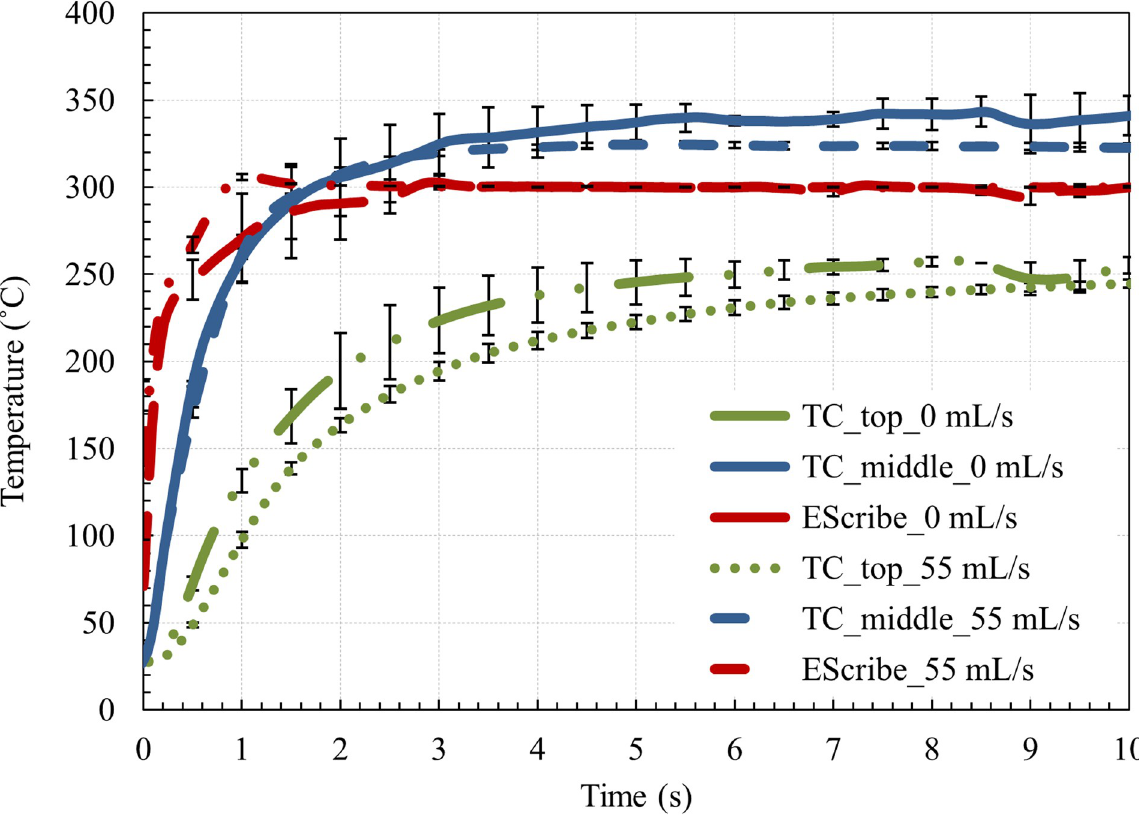
Fig 3. Coil temperature recorded by TCs and EScribe for two flow rates of 0 mL/s and 55 mL/s. Long dash dot dot green line: temperature measured at the top section of the coil for the air flow rate of 0 mL/s, solid blue line: temperature measured in the middle section of the coil for the air flow rate of 0 mL/s, long dash red line: temperature measured by EScribe for the air flow rate of 0 mL/s, dot green line: temperature measured at the top section of the coil for the air flow rate of 55 mL/s, dash blue line: temperature measured in the middle section of the coil for the air flow rate of 55 mL/s, dash dot red line: temperature measured by EScribe for the air flow rate of 55